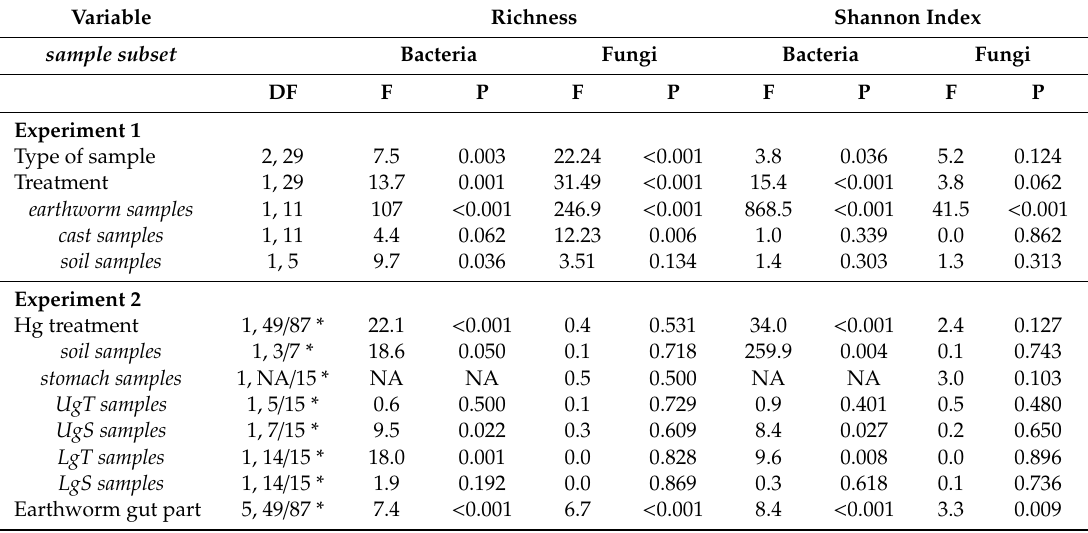
Table 2. Statistical di ff erences (ANOVA) in bacterial and fungal richness and Shannon diversity index between Hg treatments and among sample types in experiment 1 and between Hg treatments and among earthworm gut parts in experiment 2. DF = Degrees of